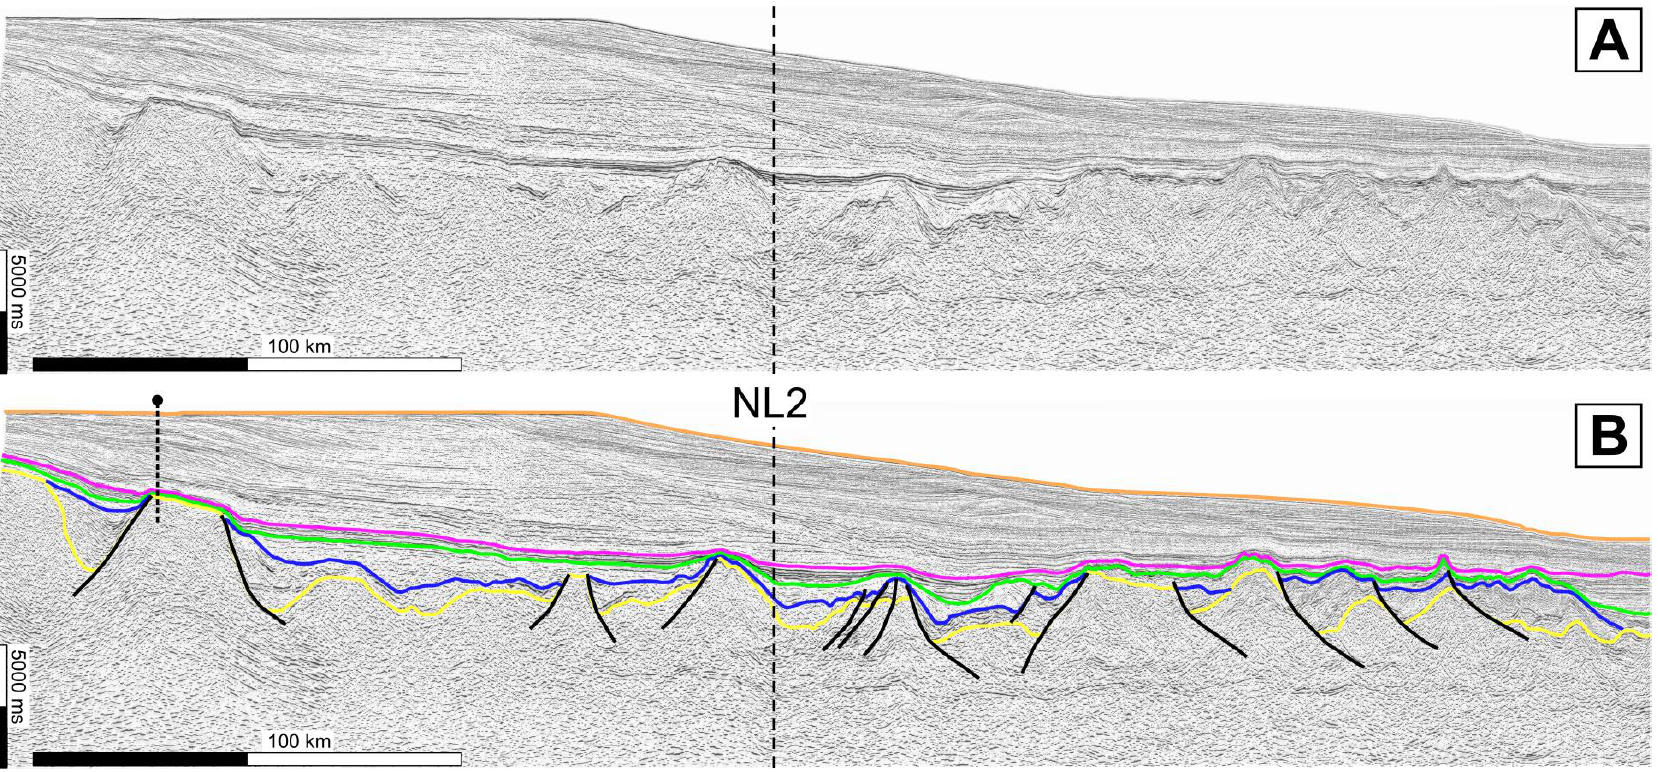
Figure 4. ( A ) Uninterpreted seismic line NL1 in the Orphan Basin (blue line in Figure 1B). ( B ) Interpreted seismic line NL1. Seismic horizons: basement, yellow; top of the Jurassic, dark blue; top of the Lower Cretaceous, green; top of the Upper Cretaceous, pink; top of the Cenozoic, orange. The solid black lines indicate faults. Location of the highlighted well (large circle in Figure 1B) is shown by dotted black line topped by the circle in panel B. The dashed black line indicates the intersection with NL2.